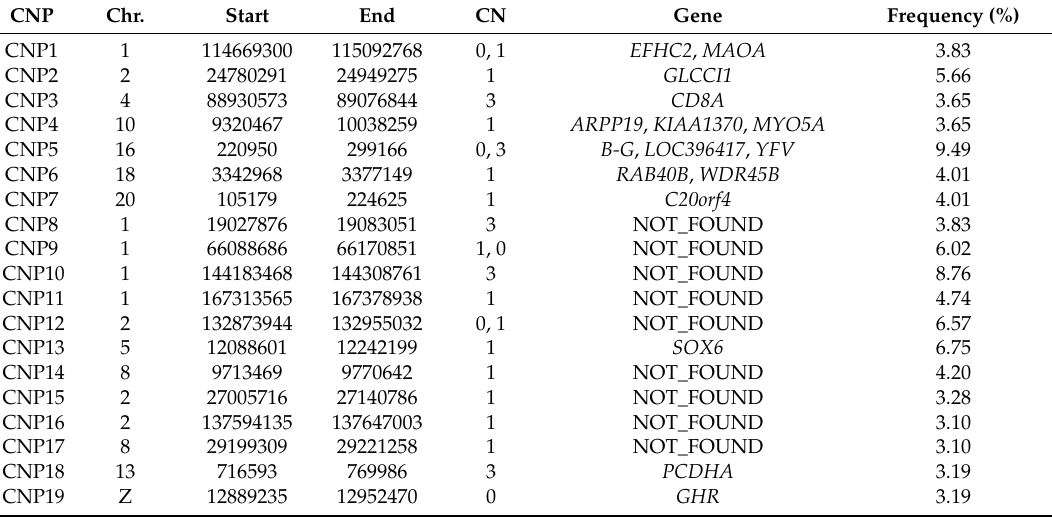
Table 1. The frequency of copy number polymorphisms (CNPs) in Xinghua chicken (XH) × white recessive rock chicken (WRR) full sib resource group.